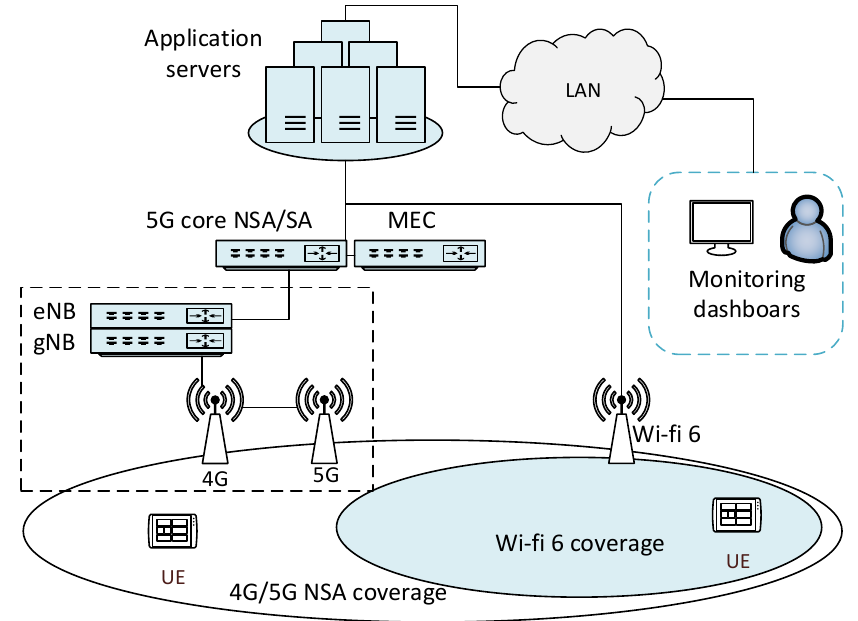
Figure 1. Architecture of the evaluation setup.